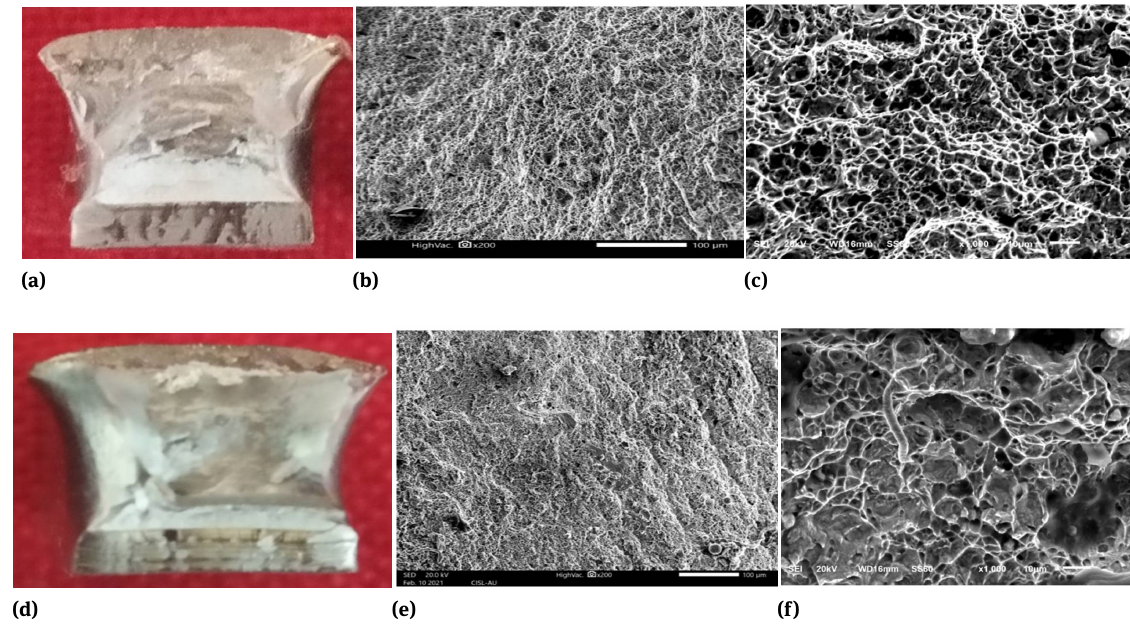
Figure 12: Fracture surfaces of BM and WM impact specimens.